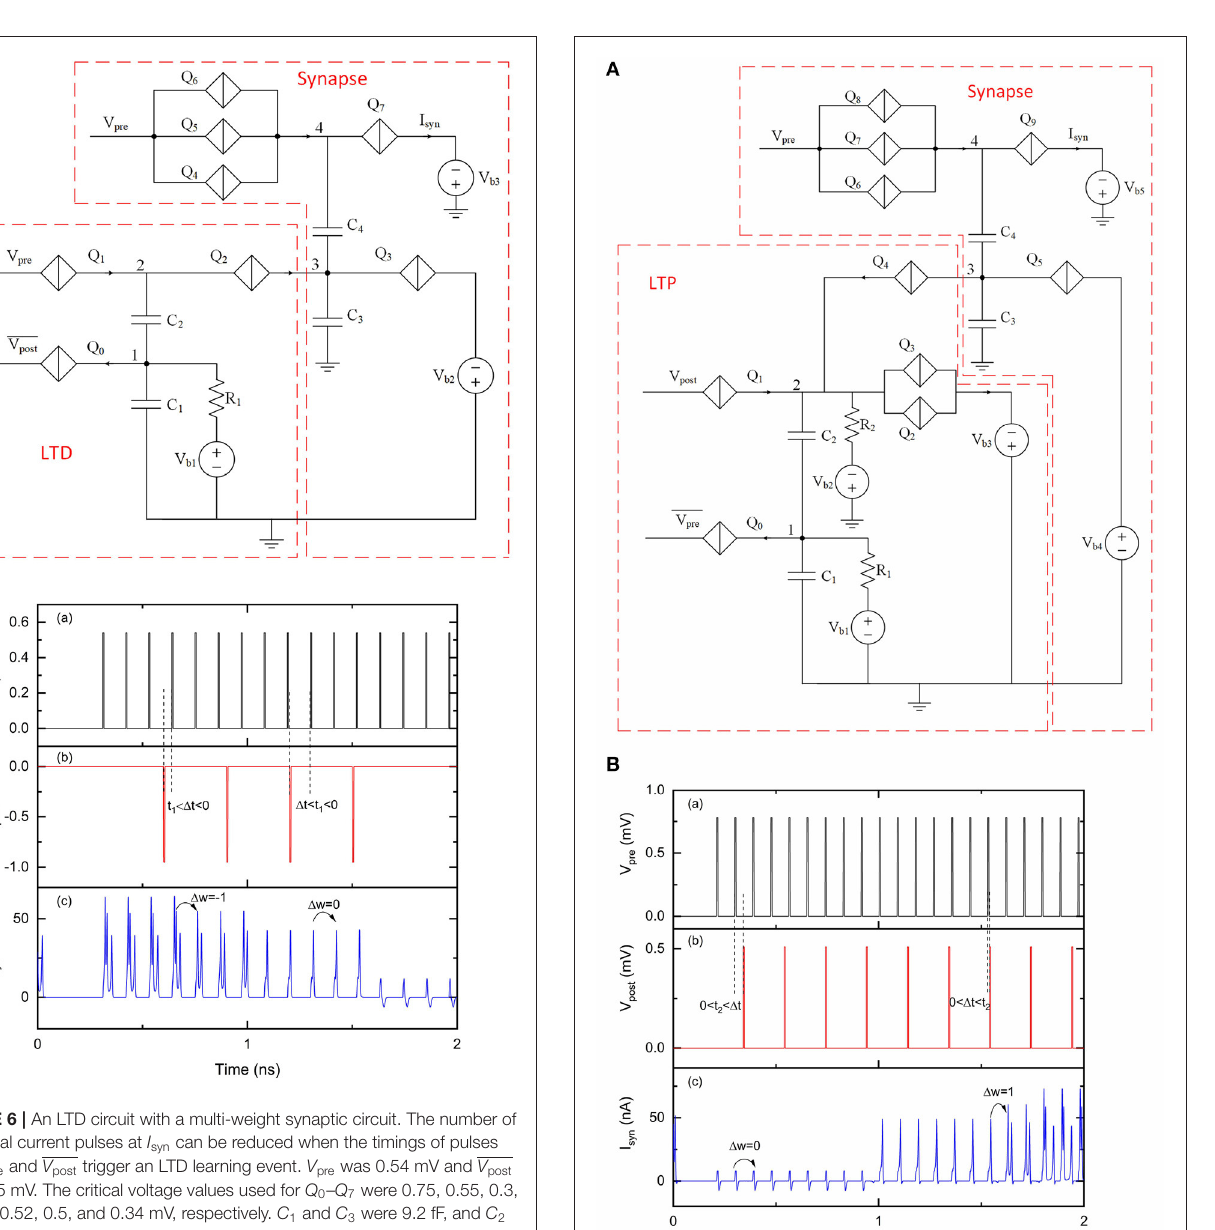
choice of resistance values and potentially adding a delay circuit (e.g., using a QPSJ transmission line circuit) for some of the input signals can adjust the LTP learning window to desired